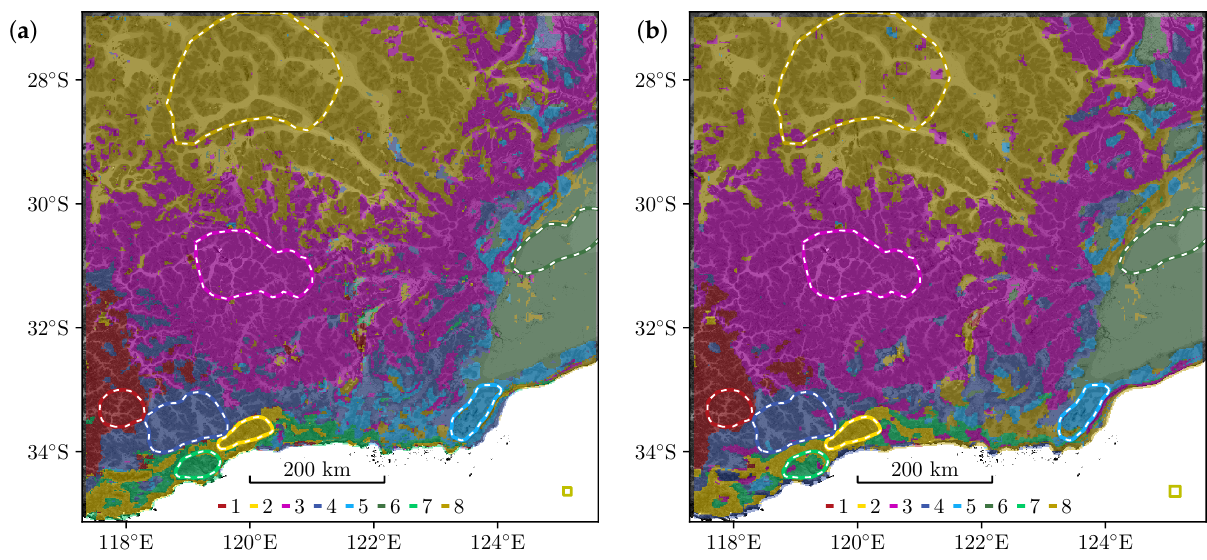
Figure 5. Best maps as produced by the remaining classifiers: ( a ) SVC-RBF at s = 13km, ( b ) SVC-LIN at s =